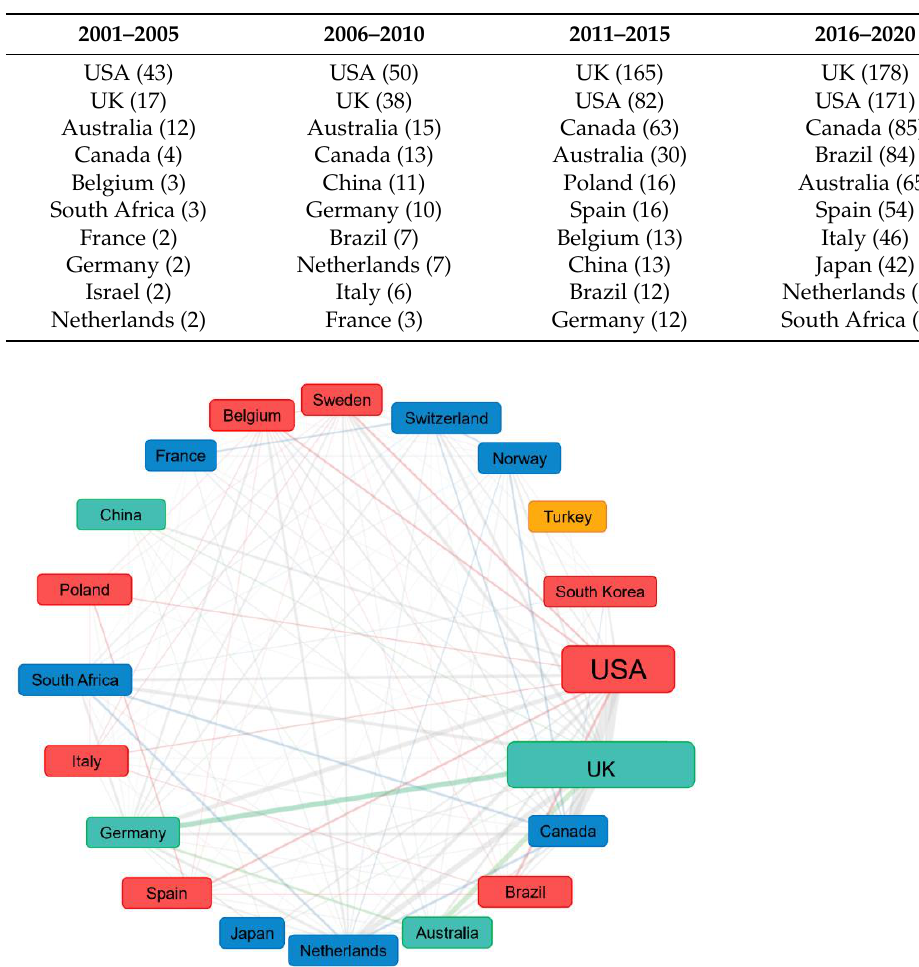
Figure 3. Top 10 productive countries on adapted sport research. Table 1. The top 10 countries of origin of papers in adapted sport research.